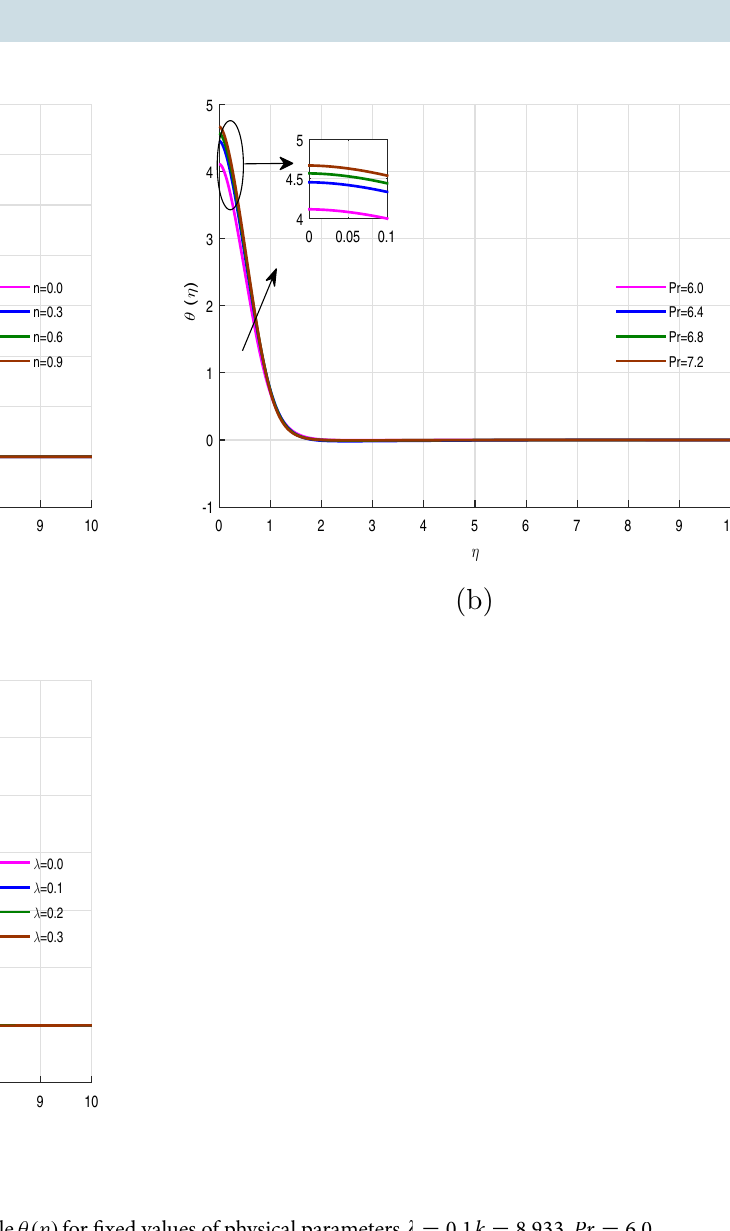
Figure 5. Temperature profile θ(η) for fixed values of physical parameters (cid:31) = 0.1 k = 8.933 , Pr = 6.0 , M = 0.5 , Gr = 0.09 , Gc = 0.05 , σ 1 = 1.1 , σ 2 = 10.9 , R = 0.5 , Ec = 0.6 , Nb = 0.01 , Nt = 0.1 Sc = 9.0 , fw = 1.0 , ϕ = 0.2 , n = 0.01 and β = 2.5 variation of parameter n , Prandtl number Pr , and heat source parameter (cid:31) respectively. In these figures, Fig. 5a shows a comparison of the linear stretching sheet ( n = 0 ) with the nonlinear stretching sheet ( n > 0 ). It can be observed that the temperature field decreases with the variation of parameter n , while enhances with the action of Prandtl number and heat source parameter (cid:31) . The thermal diffusivity of the fluid reduces with the influence of the Prandtl number, which is why the fluid temperature rises with its effect. Figure 6a–d revealed the performance of the velocity profile versus the variation of Casson fluid parameter β , parameter n , porosity parameter K , and magnetic field M respectively. Figure 6a illustrated that the velocity profile declines with the effect of Casson parameter β , and n . Figure 6b provides compression of the velocities in the case of linear stretching sheets and nonlinear stretching sheets. It is observed that the velocity for the linear stretching sheet is maximum and then as the stretching parameter increases the velocity decreases. Figure 6c,d revealed that the fluid velocity enhanced with the upshot of porosity parameter K , while reducing with the mag- netic M effect. The variation in porosity term allows more particle to pass through the pores, which encourage fluid flow, on the other hand, the magnetic force produces an opposing and resistant effect to the fluid flow, which results in the retardation of the velocity field. Figure 7a–d depicted the velocity profile behavior versus the nonlinear thermal convection σ 1 , nonlinear mass convection σ 2 , thermal Grashof number Gr and mass Grashof number Gc respectively. Figure 7a,b elaborated that the velocity field decrease with the rising effect of nonlinear thermal convection, while enhances with mass convection, because more reactant concentration is utilized by high exothermic reaction. Figure 7c,d revealed that the fluid velocity augmented with the effect of thermal and mass Grashof number. Physically, the stretching